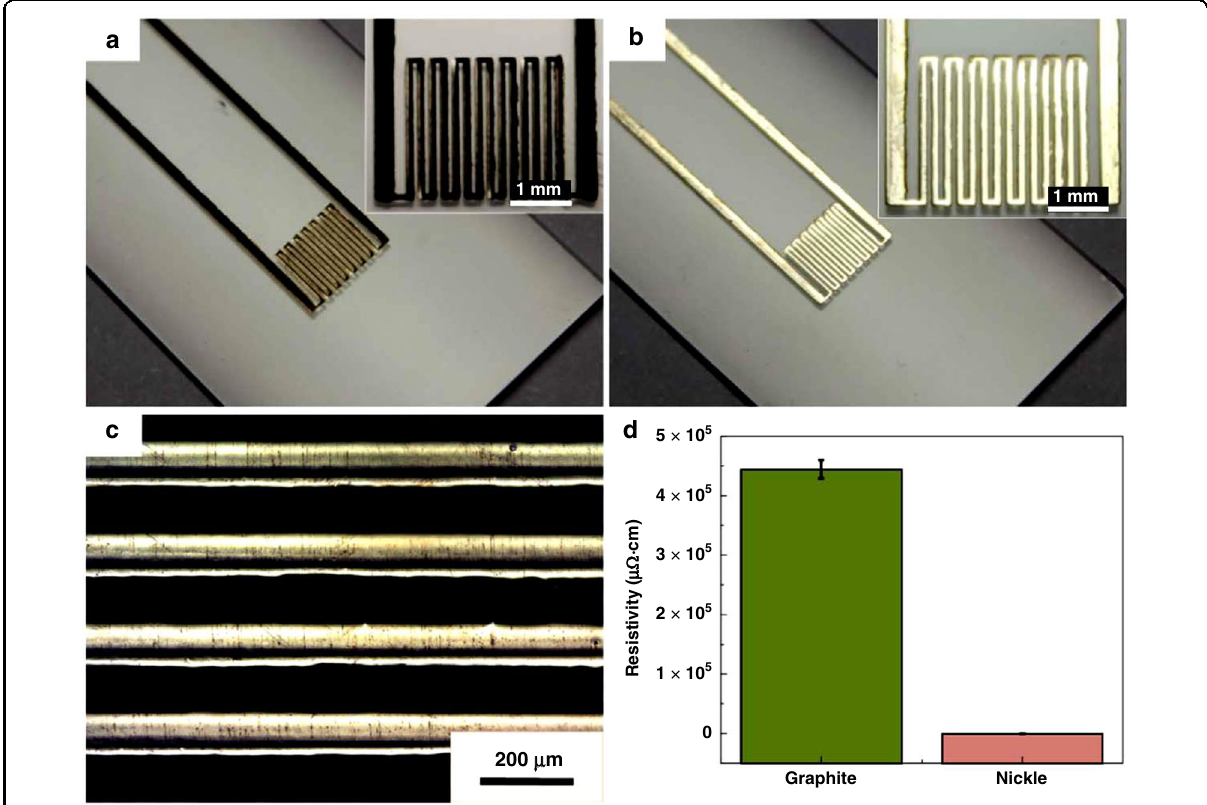
Fig. 6 Demonstration of micro-electronics devices fabricated by combining LIPAA and electroplating 66 . a Graphite patterns fabricated by LIPAA, and b , c Ni patterns coated by electroplating. d Resistivity of the graphite and Ni patterns. Reproduced with permission from ref. 66 , © 2017 Elsevier B.V. All rights